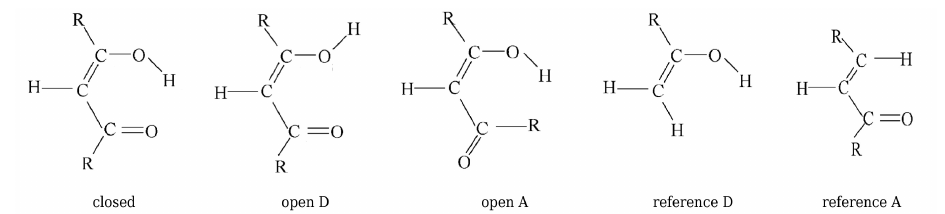
Figure 17. The closed form, the two open forms and the two reference molecules used in RBM for malondialdehyde and acetylacetone (R = CH 3 ) [33]. Table 3. Estimated values (MP2/6-31G**) of intramolecular O-H · · · O hydrogen bond energies (in kcal/mol) in malondialdehyde and acetylacetone [33].